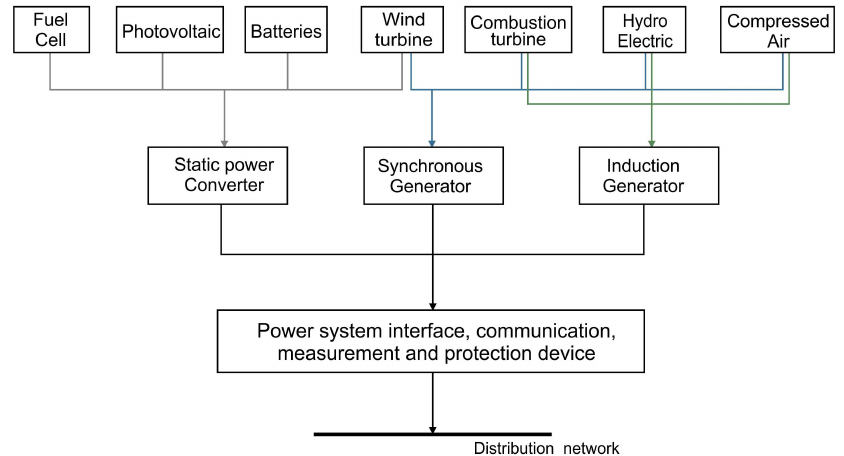
Figure 2. Combination of power converters and energy sources